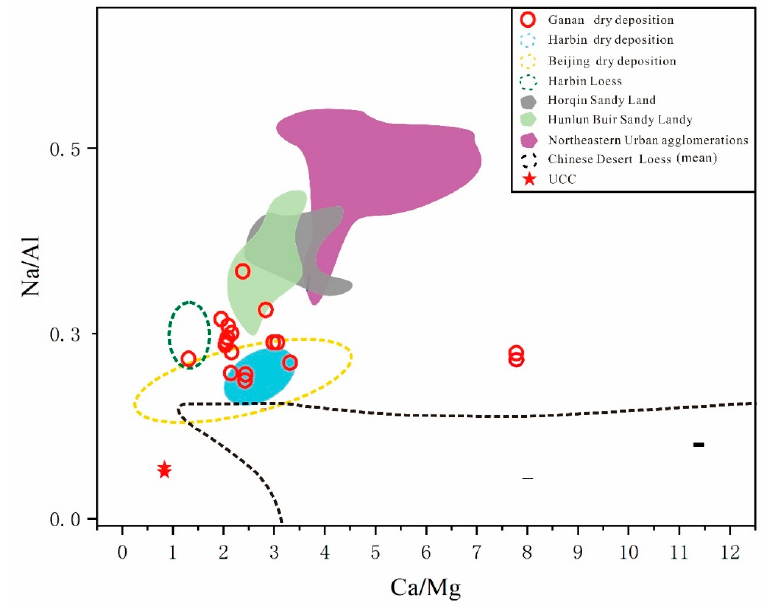
Figure 3. The correlation between the ratios of Ca/Mg and Na/Al, in comparison with the potential sources. Upper continental crust (UCC) [52], Chinese desert (mean) loess [70,81]; dry deposition of northern urban agglomerations [44]; dry deposition of Horqin Sandy Land and Hulun Buir Sandy Land [42]; Beijing dust [68]; dry deposition of Harbin and Harbin loess [46]. All data are based on the same grain size (<63 μ m component).